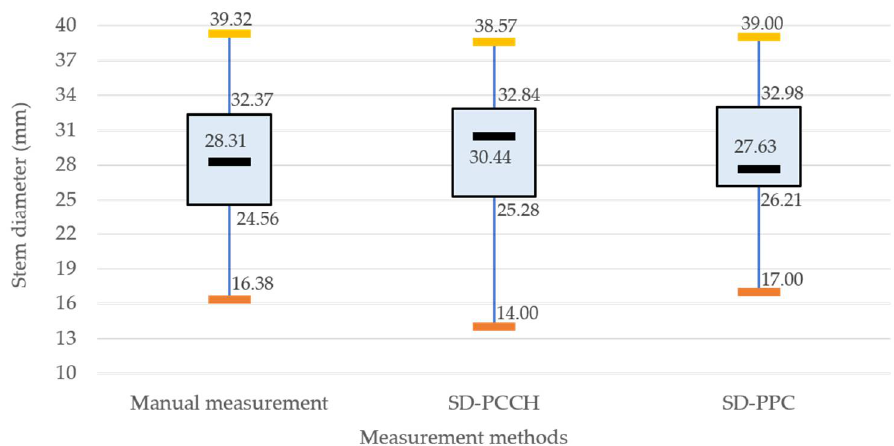
Figure 17. The measurement result distribution of the stem diameters by SD-PCCH, SD-PPC, and manual measurement.